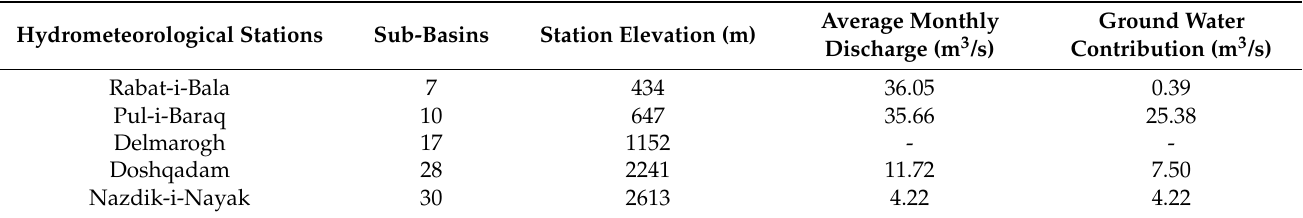
Table 1. The recorded average discharge at the stations during the non-rainy months and an estimation of the groundwater contribution based on the difference between records in the non-rainy seasons.